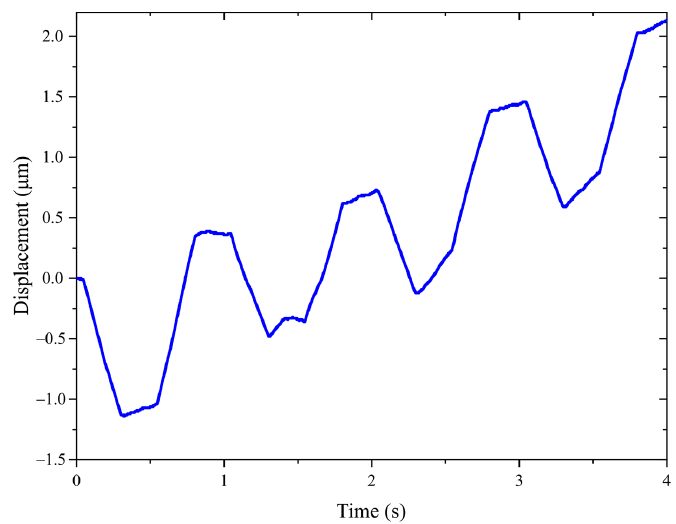
Figure 11. The step distance test curve under driving and clamping voltage amplitudes are 12 V and 30 V, respectively.